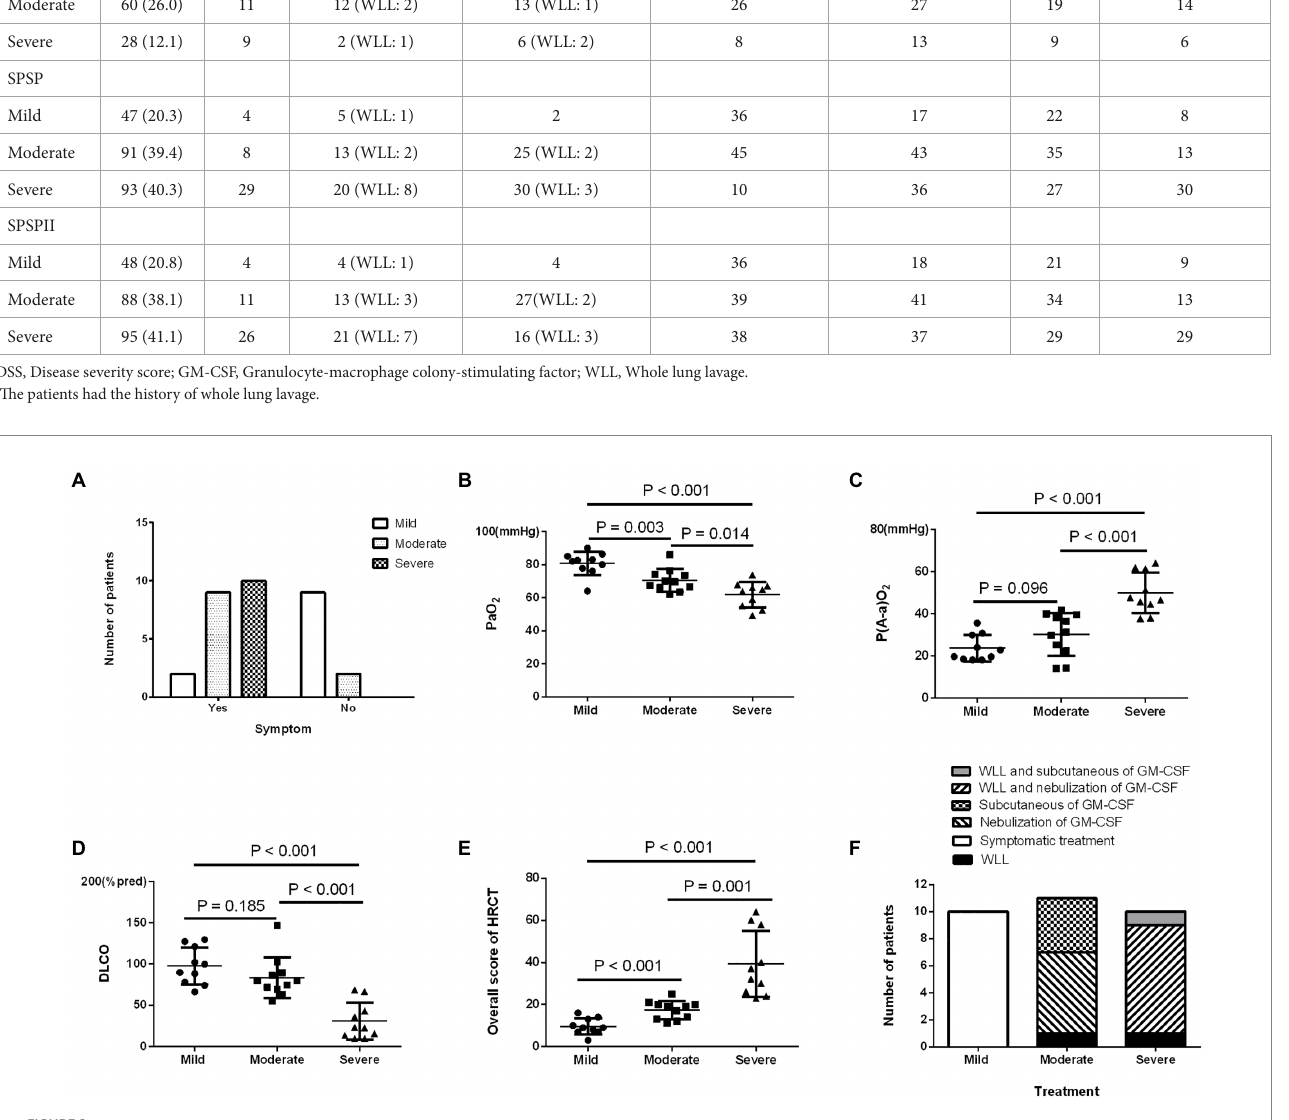
FIGURE 2 The characteristics and prognosis of patients with different SPSPII-based severities in the prospective study. (A) Symptoms . (B) PaO 2 . (C) P(A-a) O 2 . (D) DLCO. (E) Overall HRCT score. (F) The treatment options of patients with different